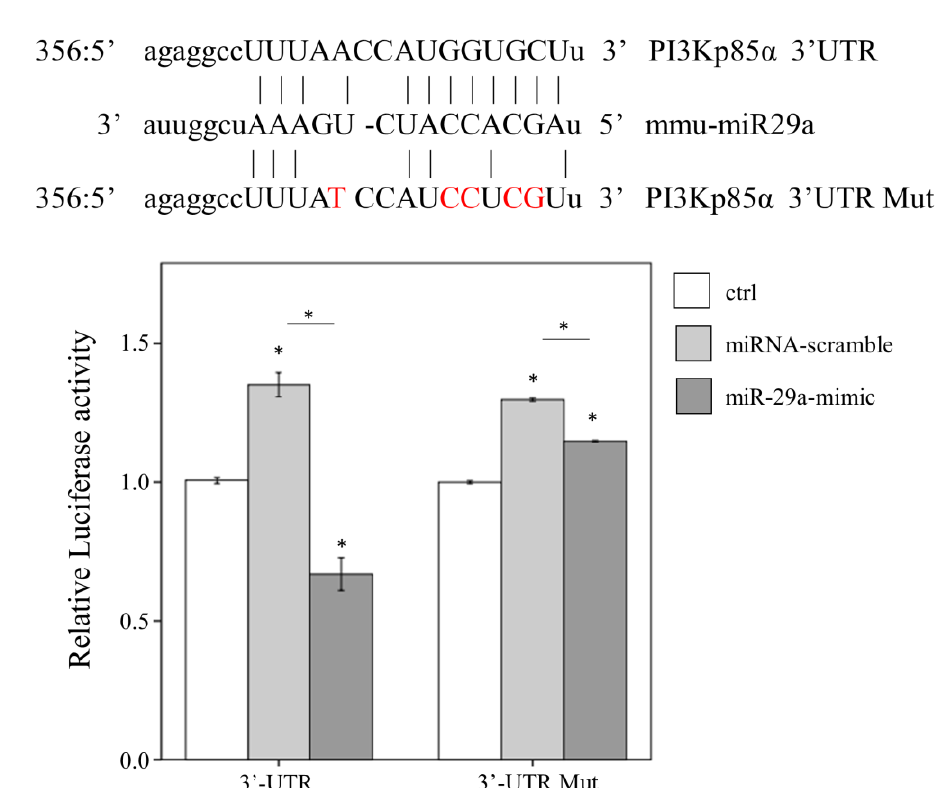
Figure 4. Interaction of miR-29a with the 3 (cid:48) UTR of PI3Kp85 α by luciferase assay. Shown above is the sequence information and mutual binding status of PI3Kp85-3 (cid:48) UTR, mmu-miR29a, and PI3Kp85-3 (cid:48) UTR Mut. The nucleotides in red indicate mismatching sites. HepG2 cells were firstly transfected with PI3Kp85 α -3 (cid:48) UTR or PI3Kp85 α -3 (cid:48) UTR mutant luciferase reporter plasmid, then treated with control medium (ctrl), miRNA-scramble, or miR-29a mimic, and finally lysed to detect the luciferase signal. Three independent experiments (N = 3) with at least triplicate for each experiment were conducted. Data expressed as mean ± SE. * indicates a p < 0.05 between the groups. mmu-miR29a, mouse-origin miR-29a. ctrl, control. Mut, mutant. UTR, untranslated region.